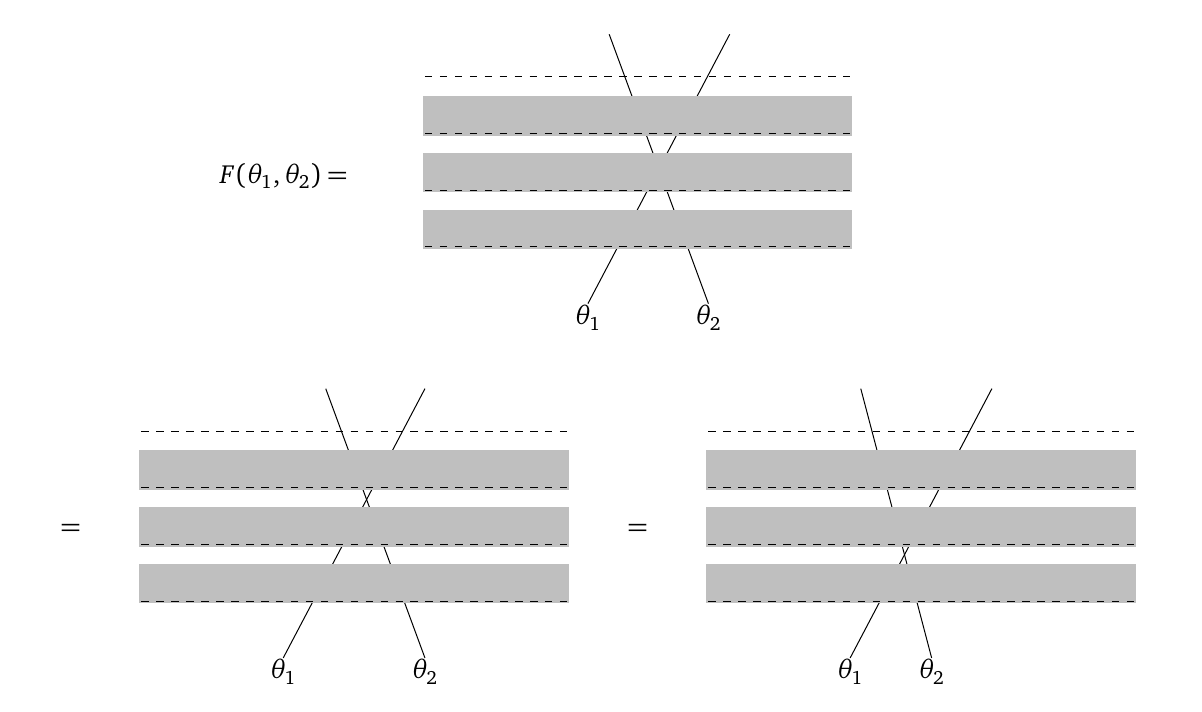
Figure 7: Floquet Yang-Baxter